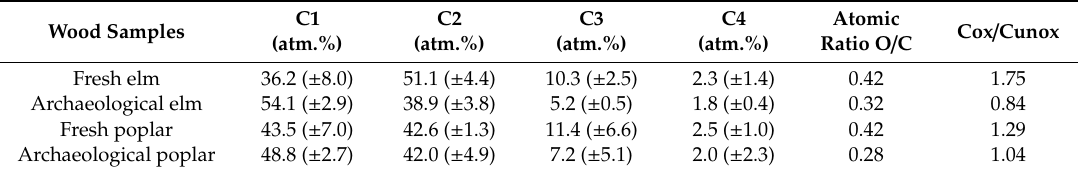
Figure 1. High-resolution spectra of the C1s energy level of ( a ) fresh elm, ( b ) archaeological elm, ( c ) fresh poplar, and ( d ) archaeological poplar. Table 1. Relative surface composition for fresh and archaeological elm and